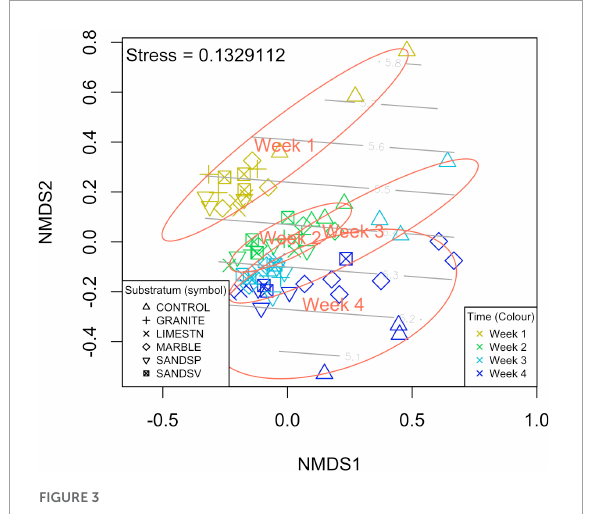
FIGURE3 nMDS plot shows that that α and β diversity of the meta-contigs clearly separate over the y -axis suggesting that biofilm age is a factor of interest. Colors signify biofilm age: Gold = Week1, Green = Week2, light blue = Week 3, and dark blue = Week 4. Light gray contour lines indicate the Shannon Wiener diversity (H (cid:48)